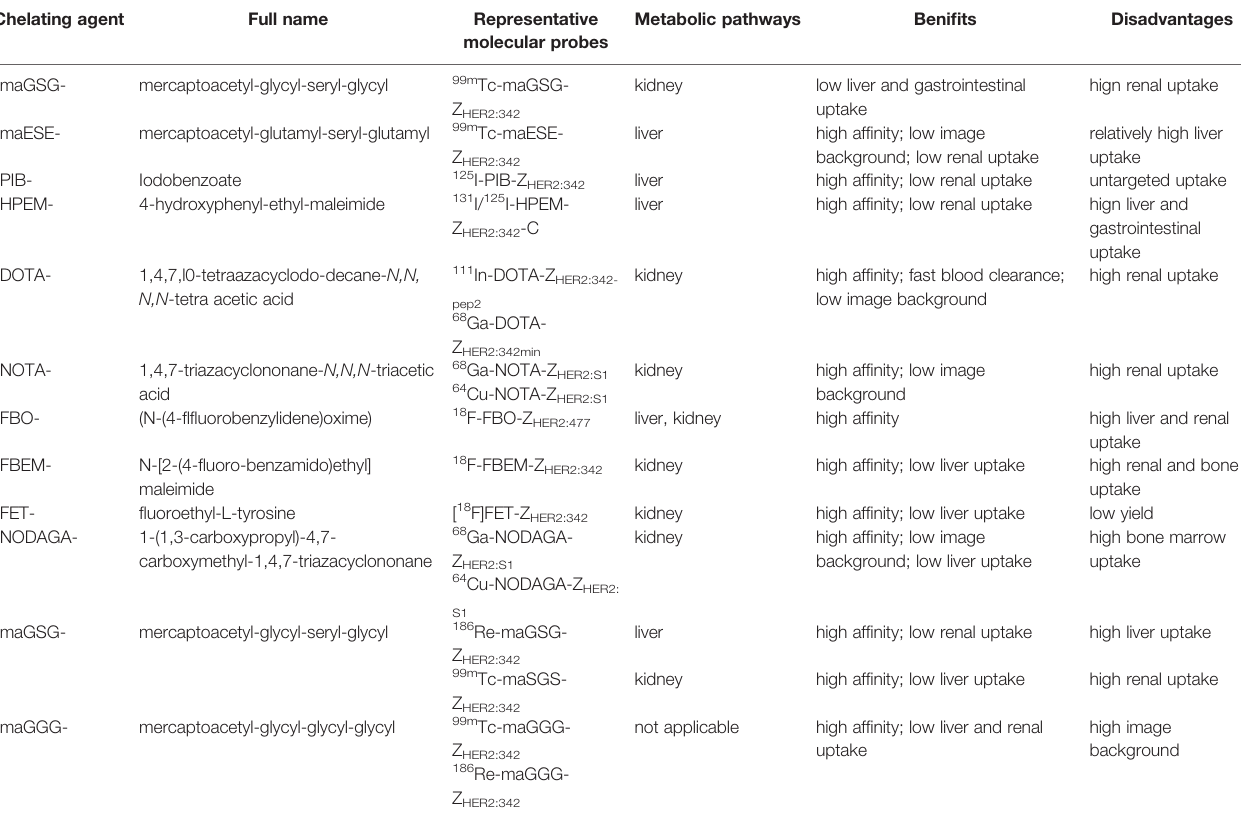
TABLE 2 | Overview of advantages and disadvantages of commonly used chelators as molecular